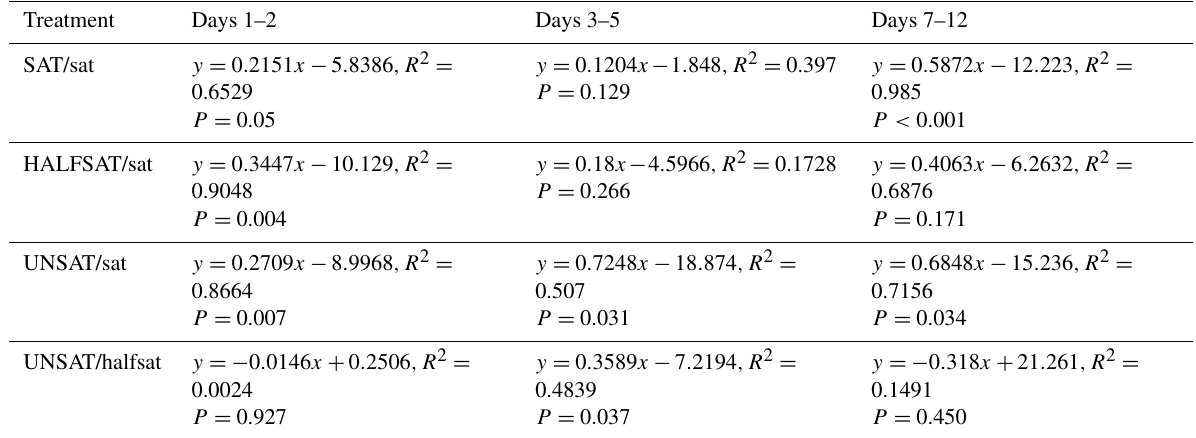
Table 7. Equations of fitted functions and correlation coefficients corresponding to Fig. 5 for site preference (SP) ( y axis) vs. δ 18 O ( x axis) in all treatments for three periods. Correlations are unadjusted; the P value tests whether the slope is different from zero. Treatment Days